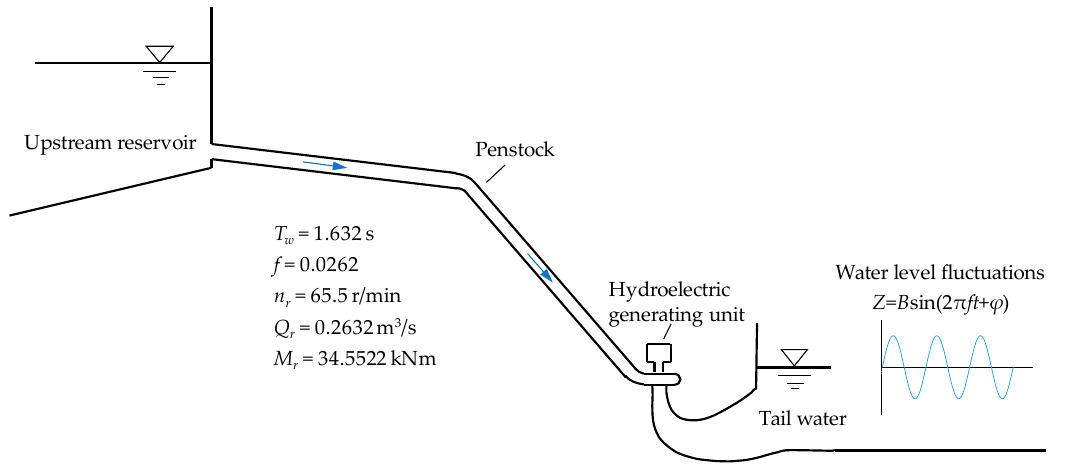
Figure 5. Schematic diagram of a small hydroelectric power plant.